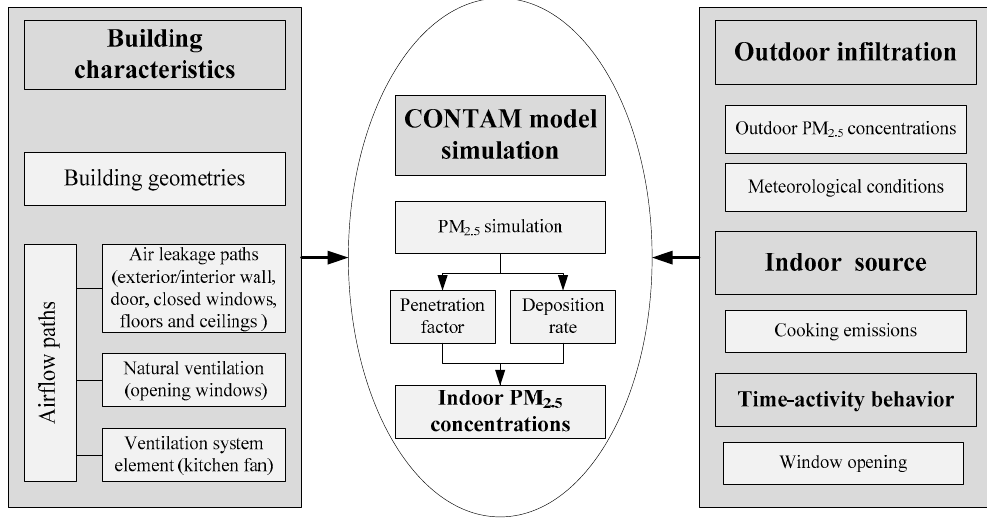
Figure 3. Conceptual diagram of the CONTAM model simulation approach.